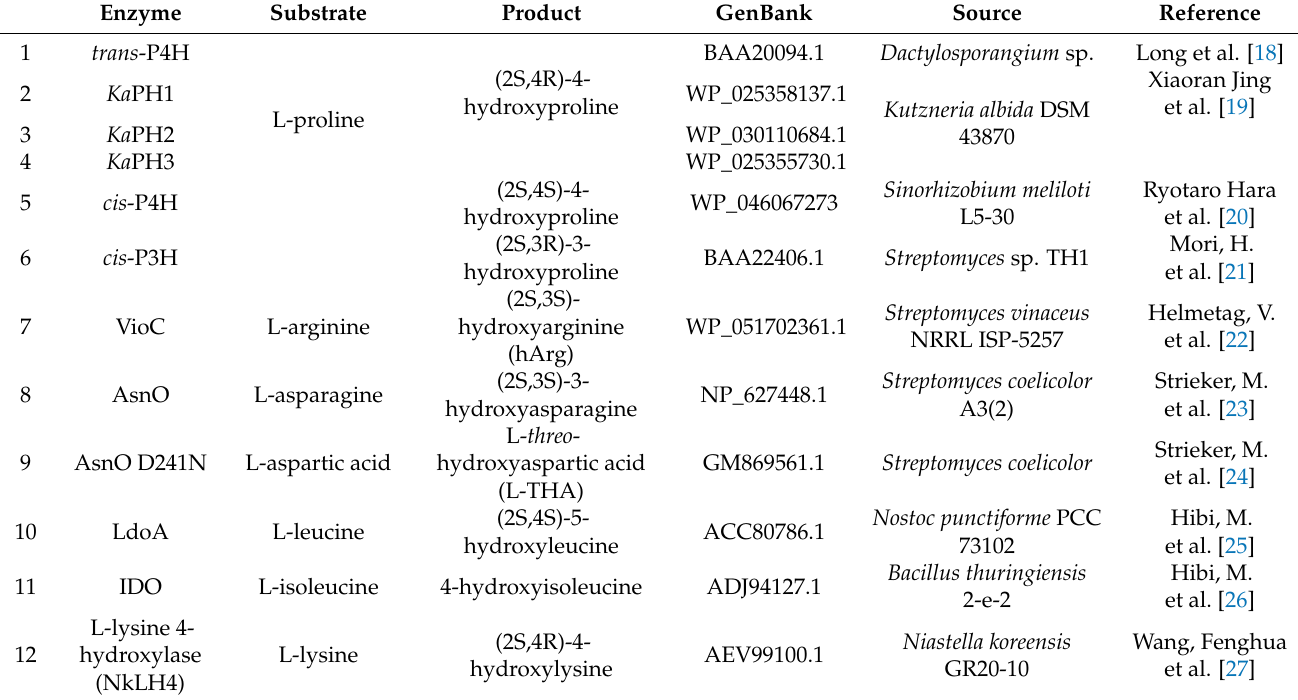
Table 1. Fe (II)/2-OG-dependent dioxygenase candidates for catalyzing amino acid